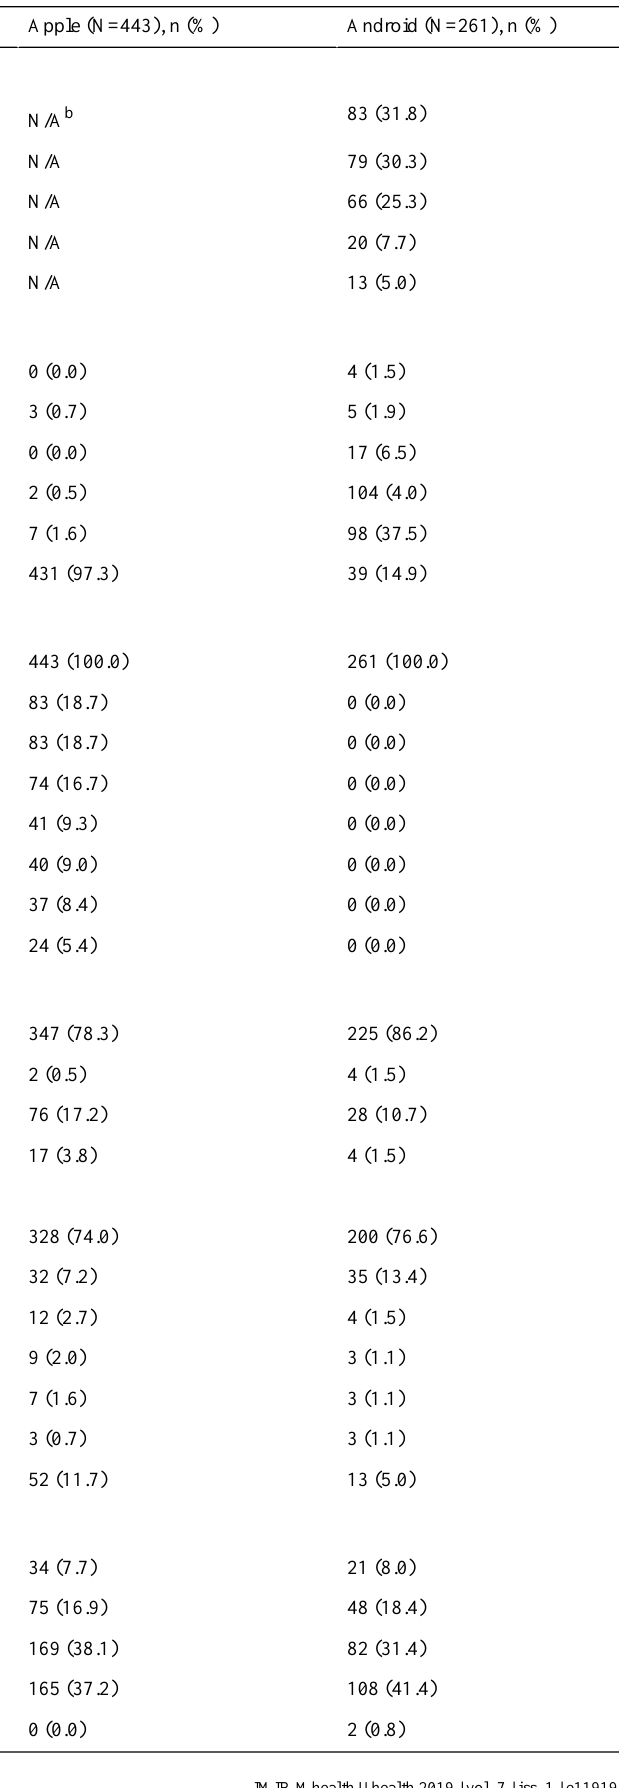
Table 1. Characteristics of included mobile phone medication adherence